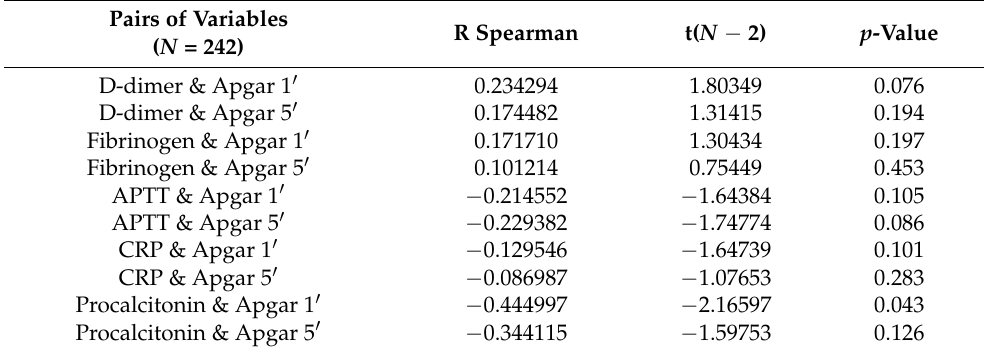
Table 5. Selected blood parameters of SARS-CoV-2-infected pregnant women versus neonatal condi- tion assessed with Apgar